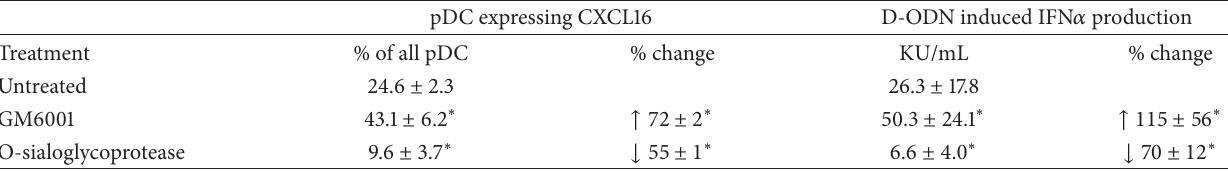
Table 1: Altering CXCL16 expression influences “D” ODN induced cytokine production.